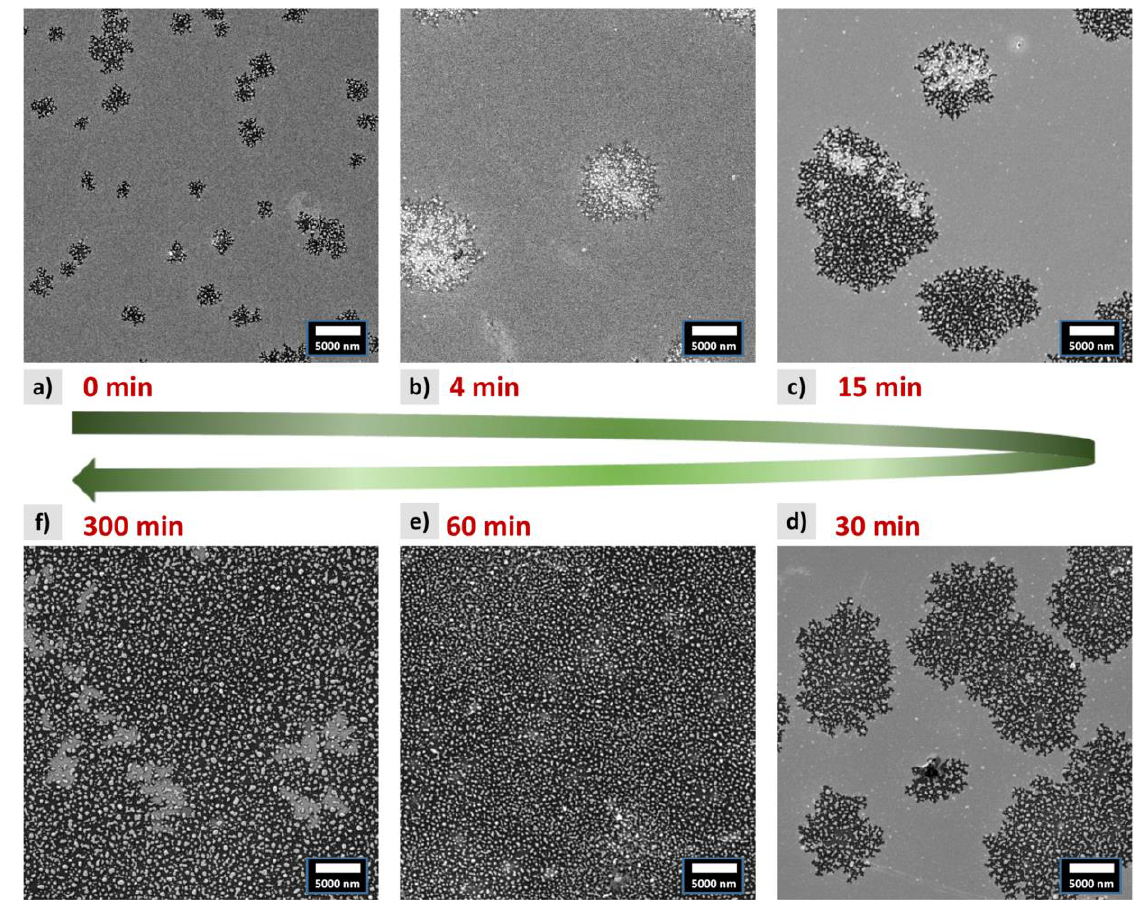
Figure 2. SEM studies of morphology evolution as a function of annealing time for the FePd alloy thin film.